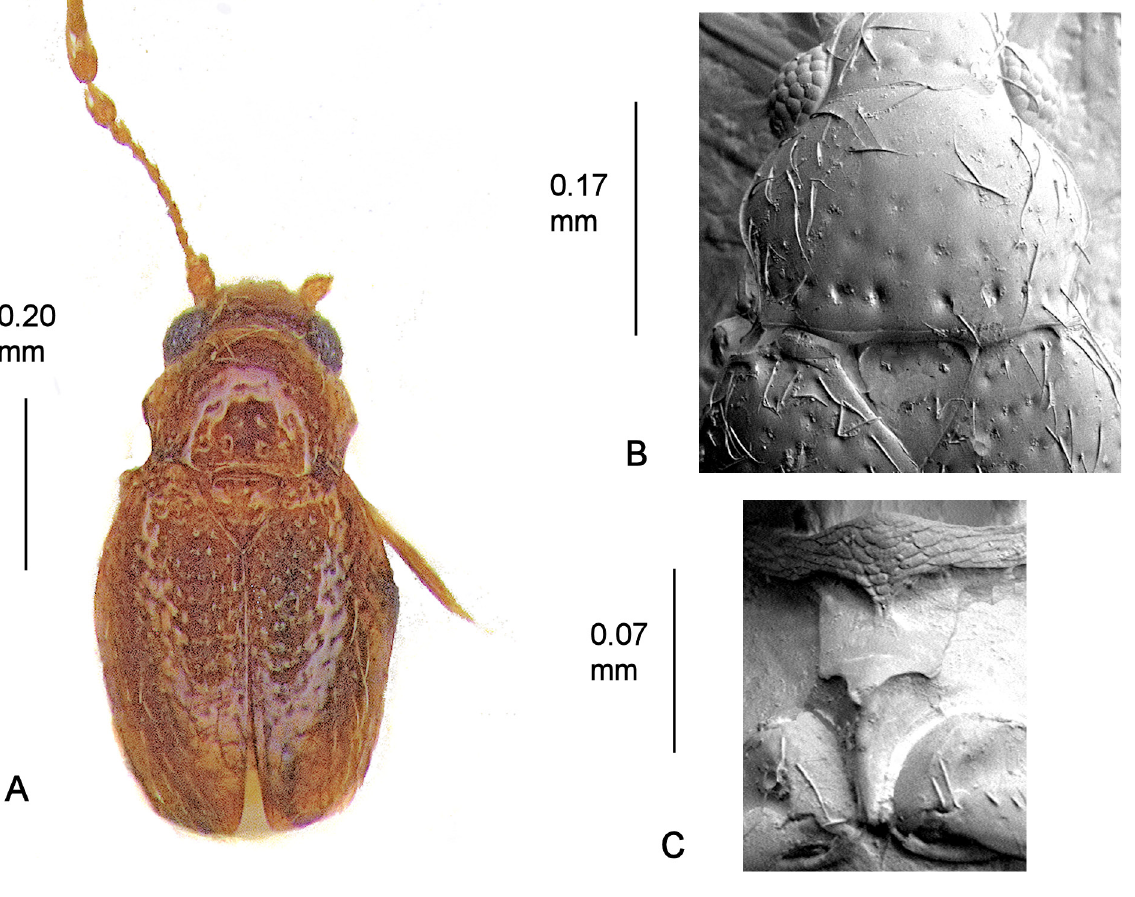
Fig. 31 . Cissidium lawrencei sp. nov. A . Habitus. B . Pronotum, × 475. C . Mesoventrite showing median process of collar, mid-keel and keel,